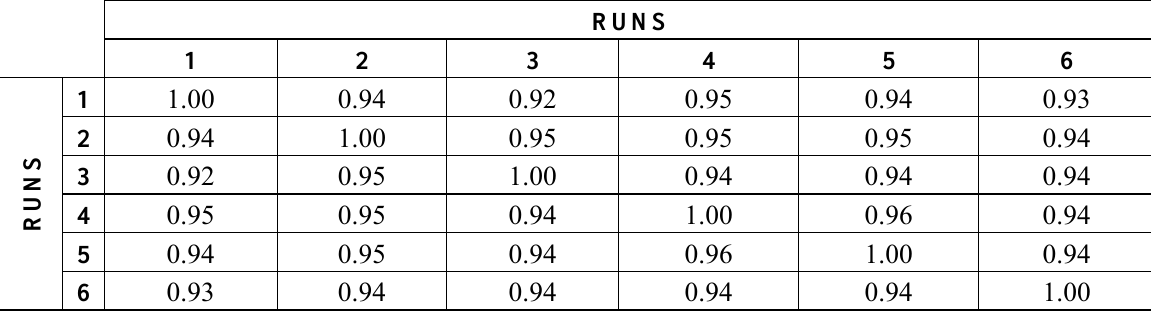
= 440 µ m and θ = 0°), showing high s